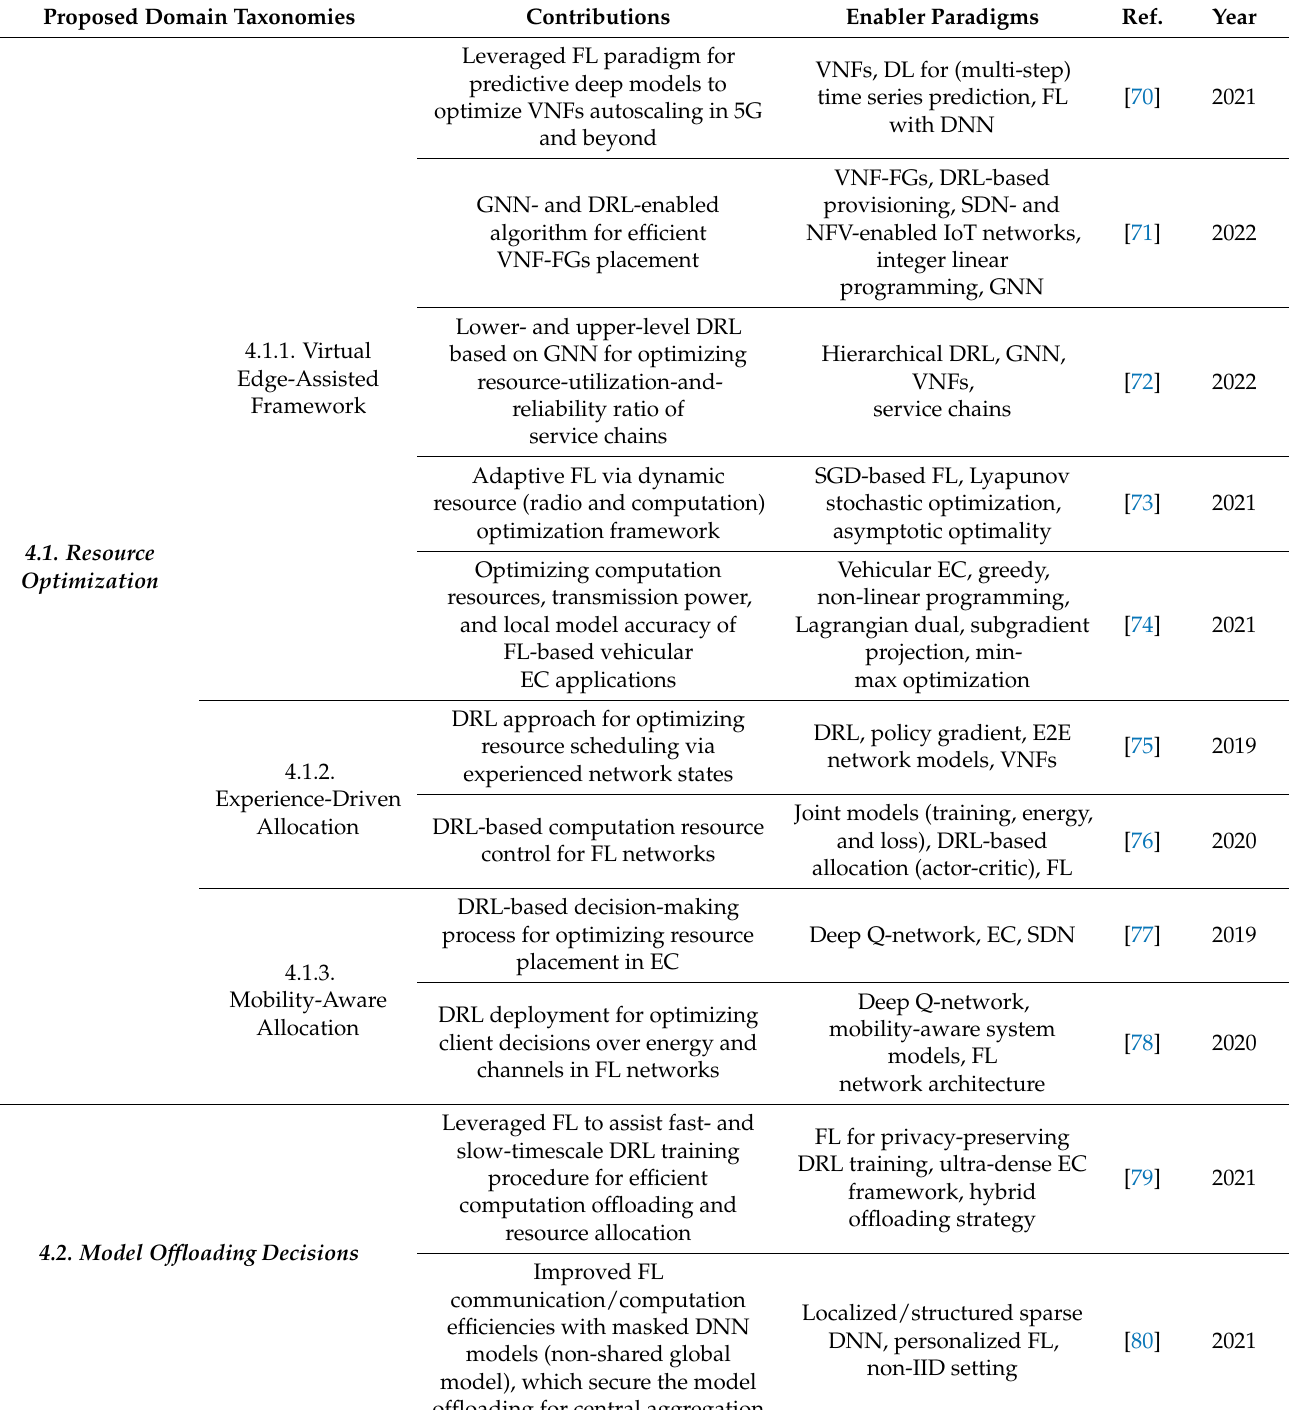
Table 4. Summary of Selected Works in Section 4, including Primary Domain Taxonomies, Contribu- tions, and Enabler